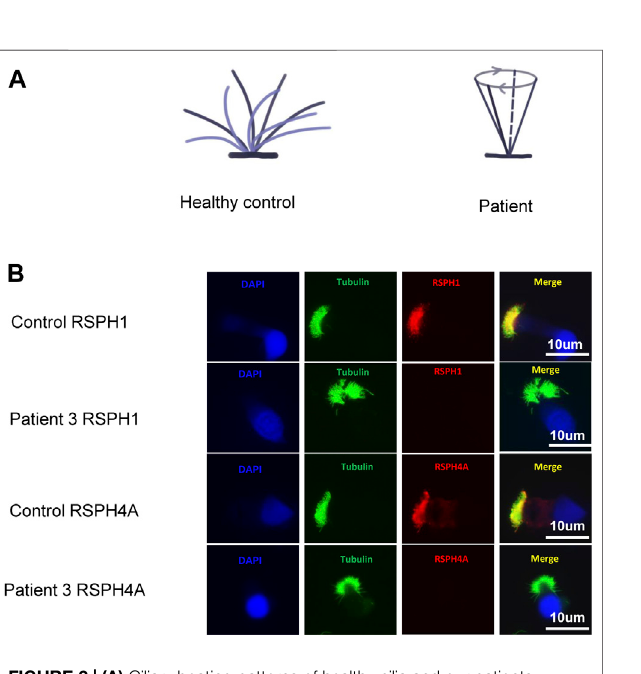
FIGURE 2 | (A) Ciliary beating patterns of healthy cilia and our patients with RSPH4A variants. (B) Immuno fl uorescenceofnasalciliatedcellsrevealed the absence of RSPH4A and RSPH1 in patient 3 (red). An anti-acetylated tubulin monoclonal antibody was used to mark the ciliary axoneme (green), and DAPI was used to label the nuclei